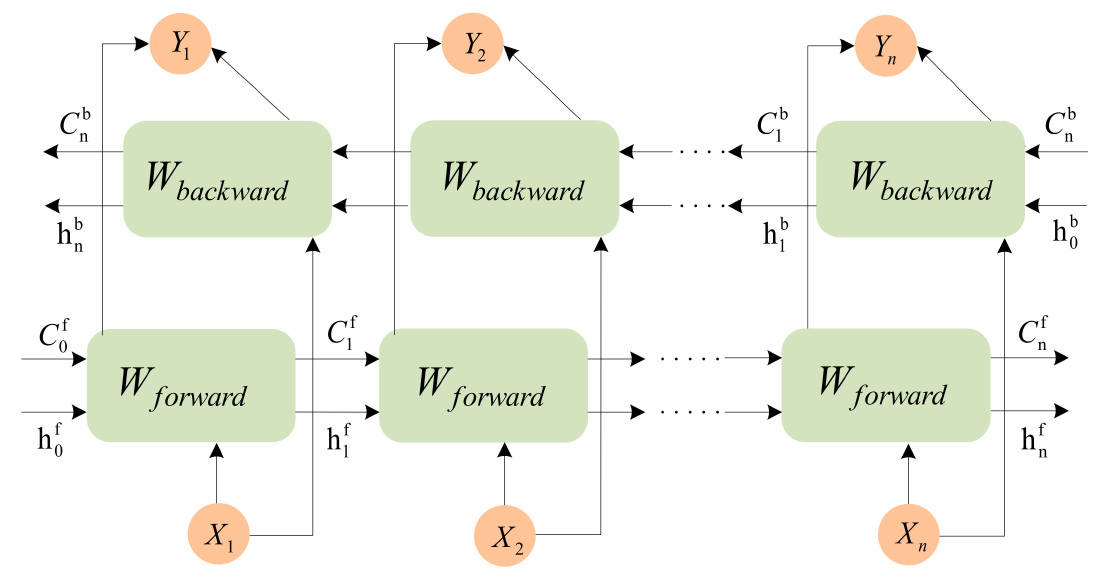
Figure 4. The schematic diagram of